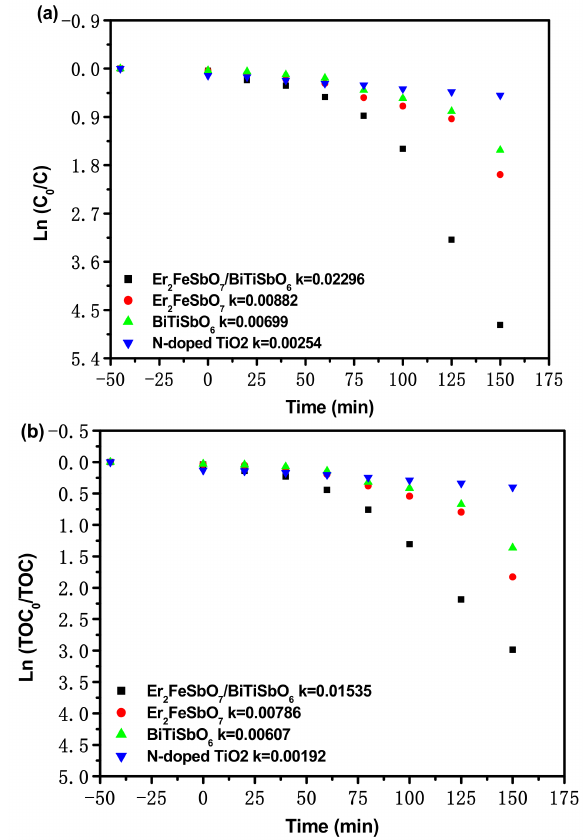
Figure 16. ( a ) Observed single-order kinetic plots for the PCD of ENR with EBH, Er 2 FeSbO 7 , BiTiSbO 6 or N-TO as photocatalyzer under VLGI. ( b ) Observed single-order kinetic plots for TOC during PCD of ENR in pharmaceutical waste water with EBH, Er 2 FeSbO 7 , BiTiSbO 6 or N-TO as photocatalyzer under